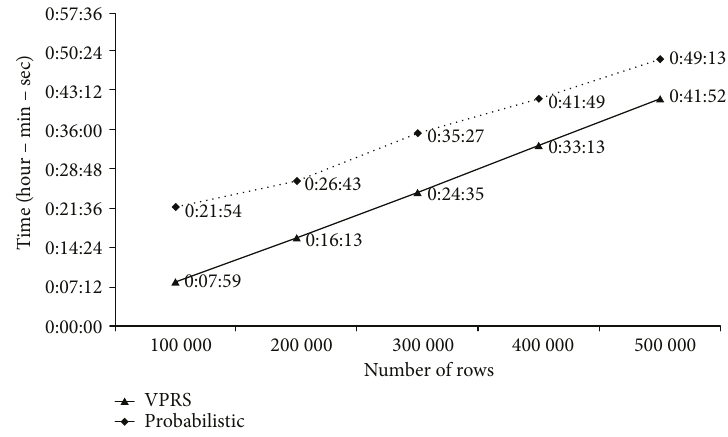
Figure 5: Comparison of run-times between the VPRS and βμ _PROB